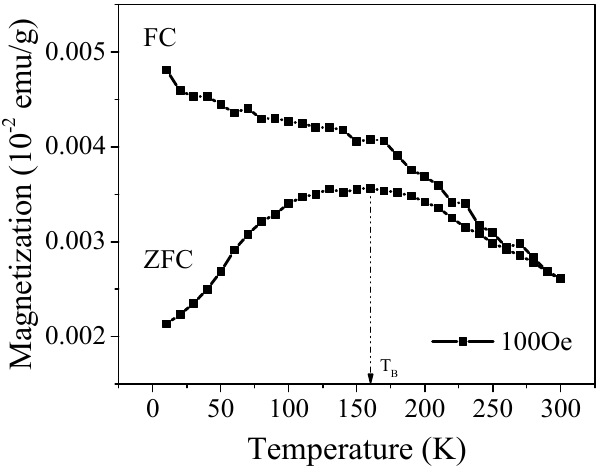
Figure 11. ZFC/FC